Question: Express in one sentence what the figure is showing.
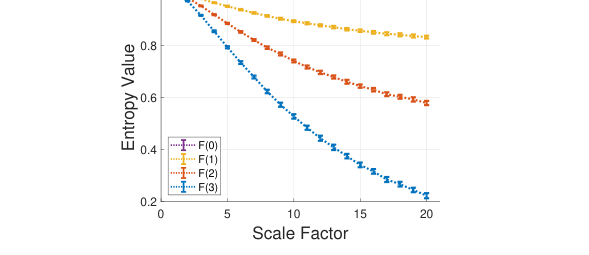
Answer: Mean value and standard deviation (SD) for the classical multivariate Dispersion Entropy mvDE.